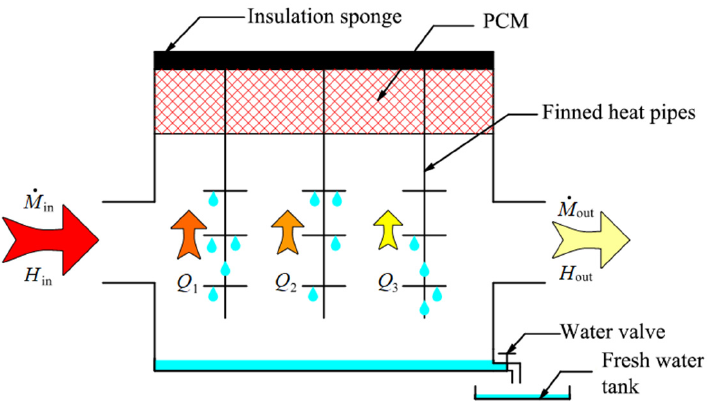
Figure 3. Schematic diagram of heat exchange for the phase change heat storage dehumidifier. Table 1. Performance indexes of instruments and equipment.